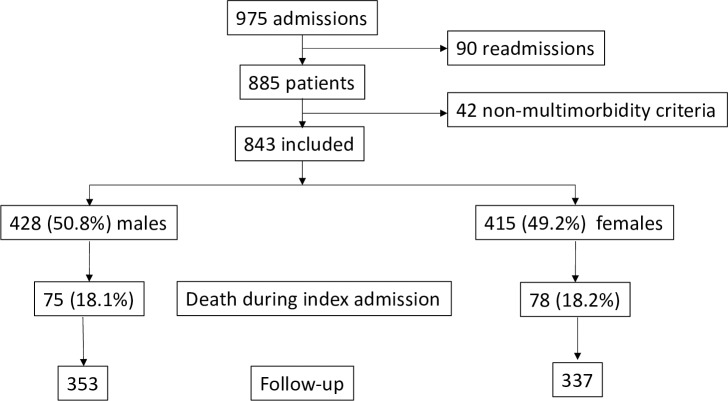
Flowchart of participants.